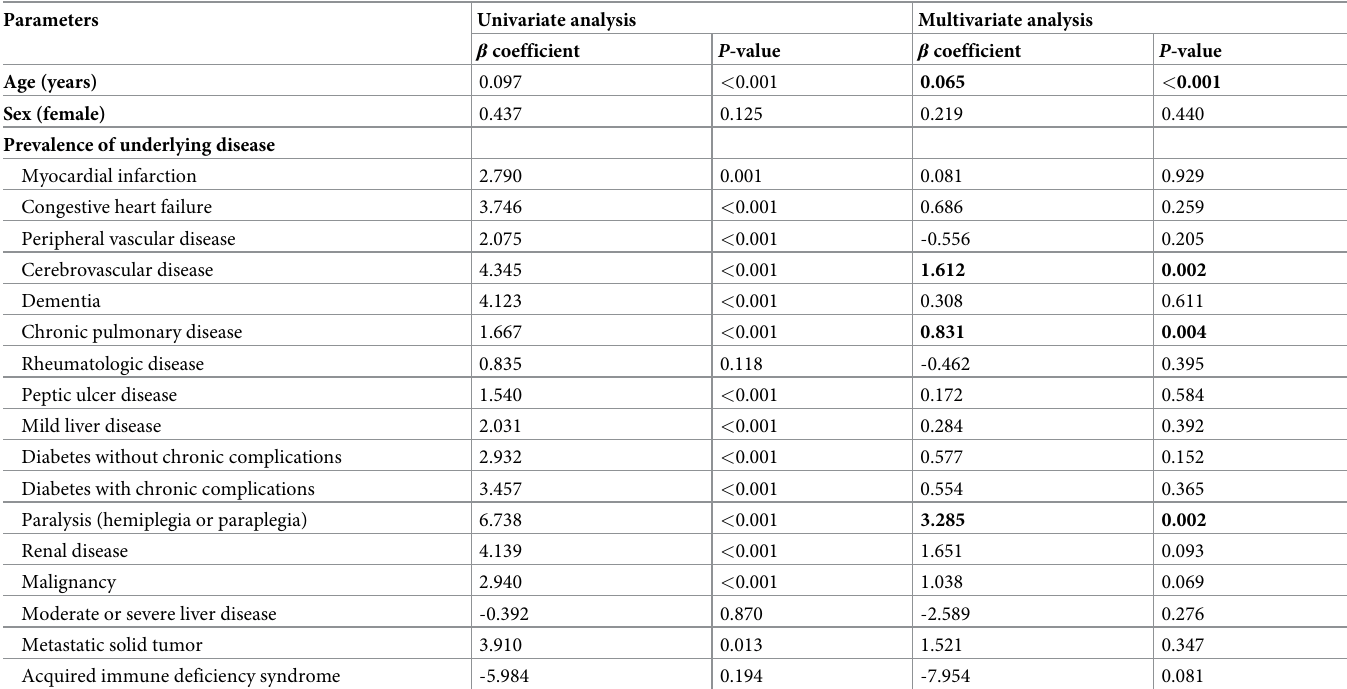
Table 4. Significant factors for admission